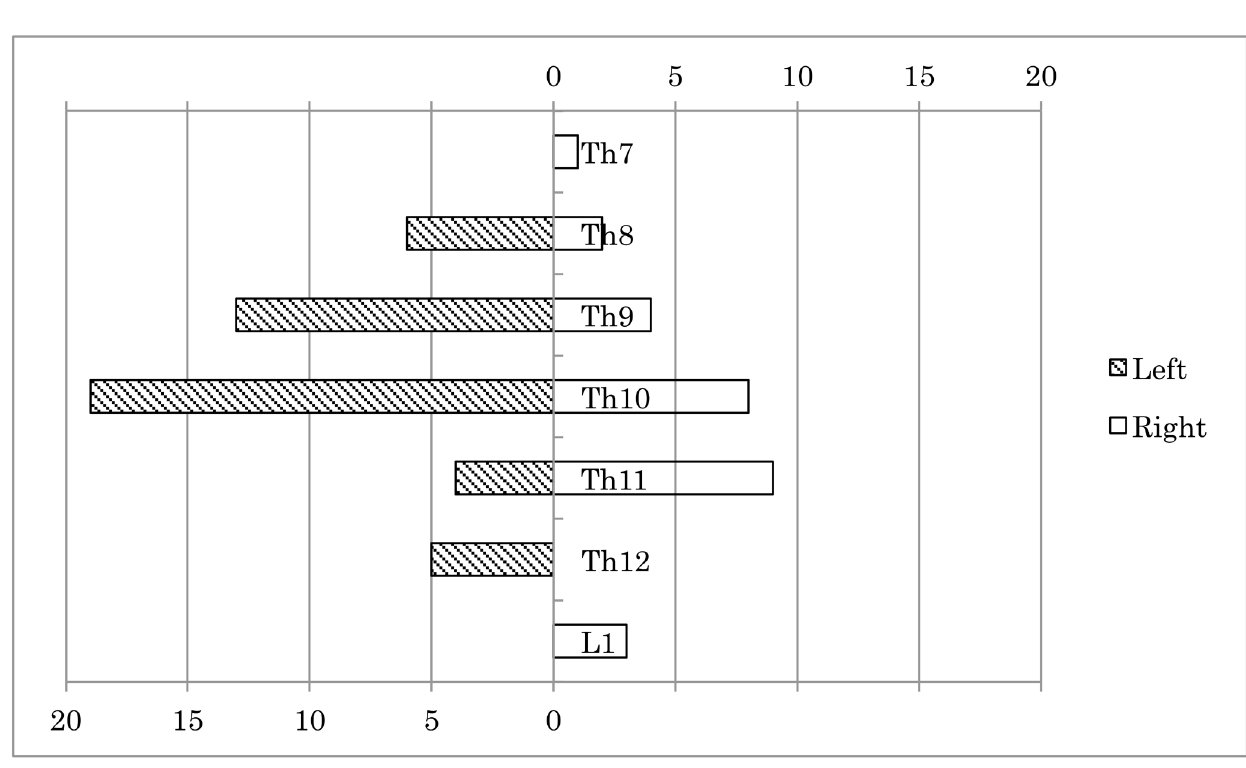
Fig. 1 - Distribution of the location of the Adamkiewicz artery.